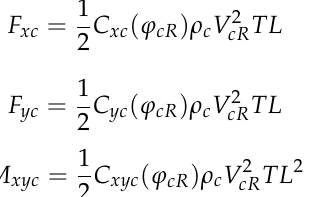
Table 3. Details of the DNV-E